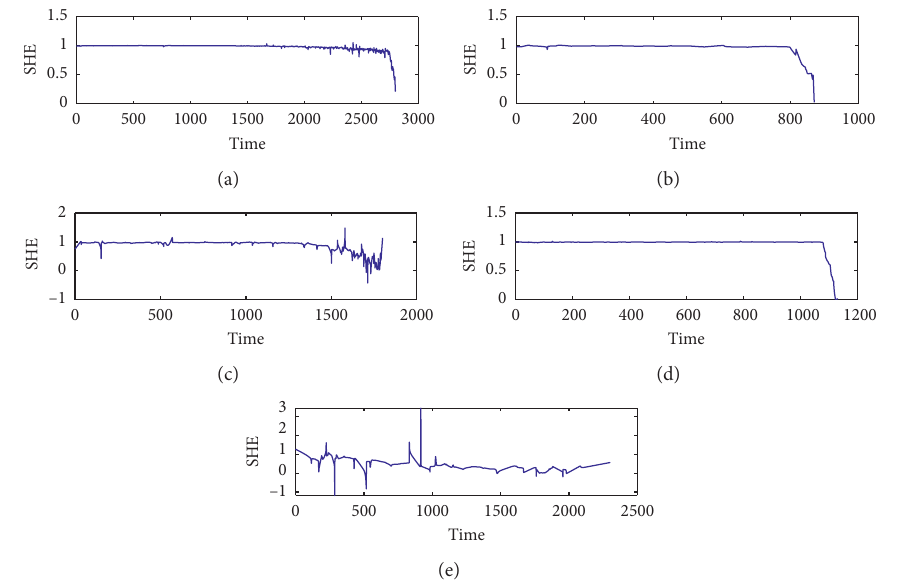
Figure 27: CVs for bearings 11–15 by using SHE. (a) Bearing 11. (b) Bearing 12. (c) Bearing 13. (d) Bearing 14. (e) Bearing 15.